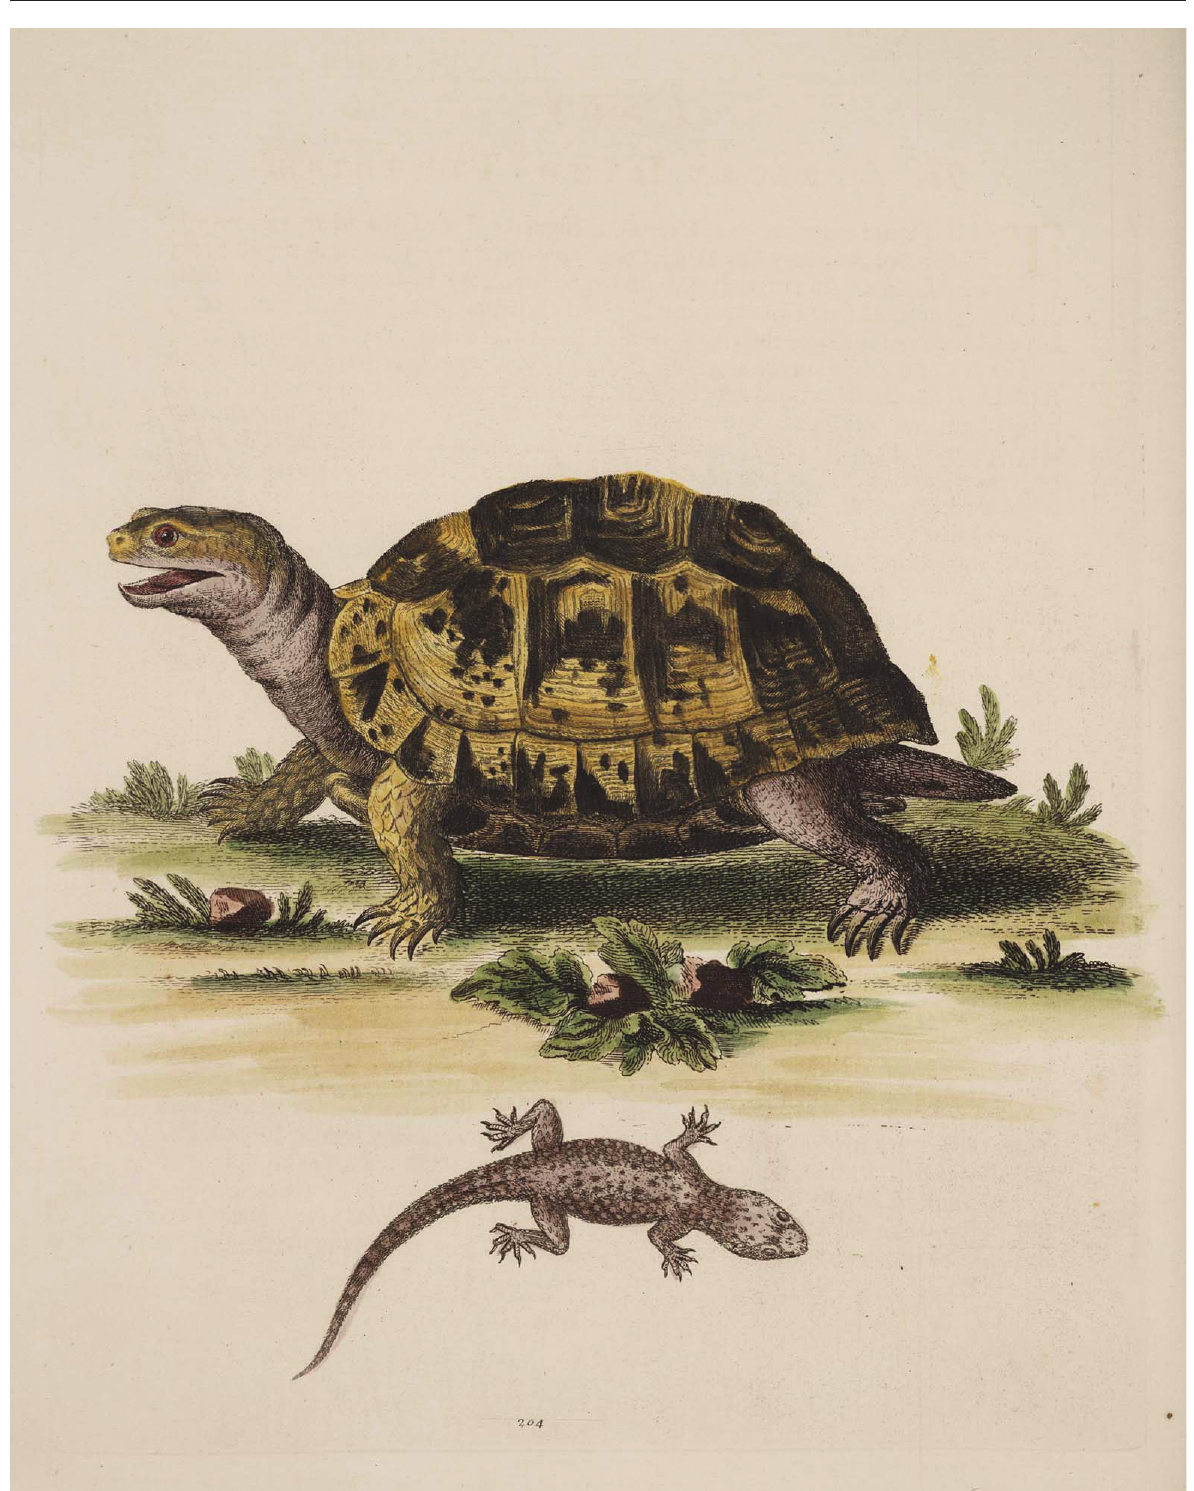
Figure 1. Plate 204 out of Edwards, G. (1751): “A natural history of birds. The most of which have not hitherto been either figured or described, and the rest, by reason of obscure, or too brief descriptions without figures, or of figures very ill designed, are hitherto but little known: Part IV” etc. Above there is “The African Land-Tortoise”, = Testudo graeca Linné.